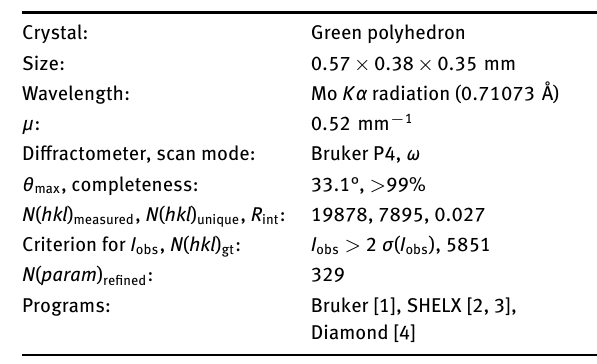
Table 1: Data collection and